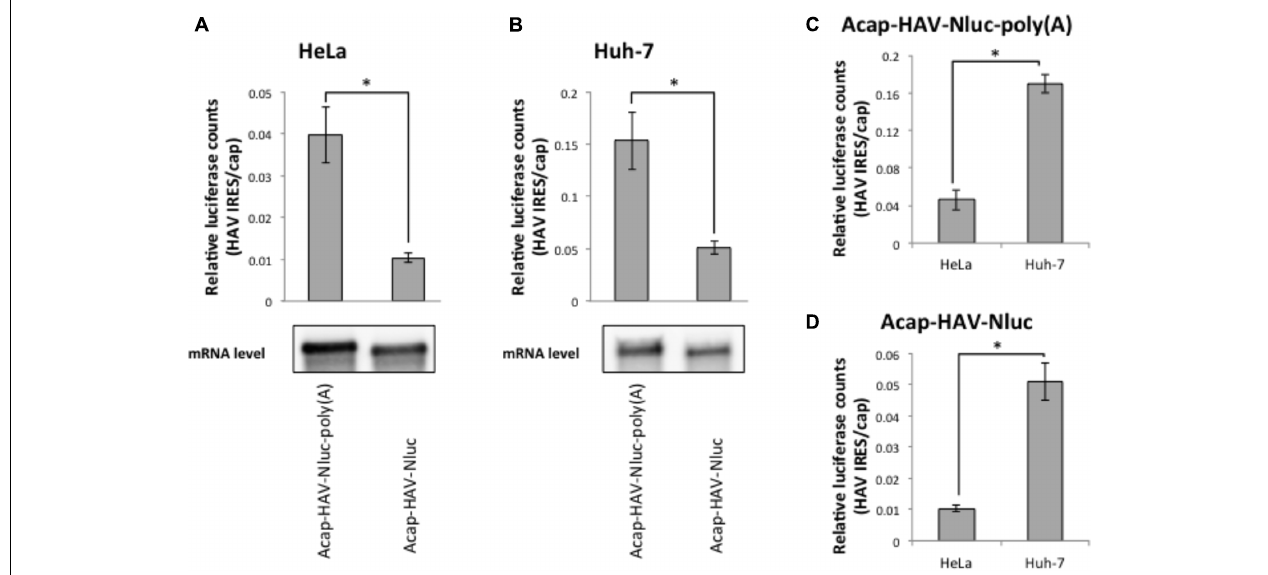
FIGURE 4 | Enhanced activity of the HAV IRES in Huh-7 vs. HeLa extracts is independent of the poly(A) tail. (top panel) HeLa (A) or Huh-7 (B) in vitro translation were performed with Acap-HAV-IRES-Nluc-poly(A) or Acap-HAV-IRES-Nluc reporter mRNAs. HAV IRES-mediated translation was normalized by cap-dependent translation. The mean values ± SD from three independent experiments are shown. (bottom panel) Physical stabilities of the Acap-HAV-IRES-Nluc-poly(A) and Acap-HAV-IRES-Nluc mRNAs at the end of the incubation were analyzed by Northern blotting. (C) Comparison of Acap-HAV-IRES-Nluc-poly(A) relative light units between in HeLa and in Huh-7 cell extracts. (D) Comparison of Acap-HAV-IRES-Nluc relative light units between in HeLa and in Huh-7 cell extracts. The asterisks indicate in (A–D) statistically significant differences ( p < 0.05).